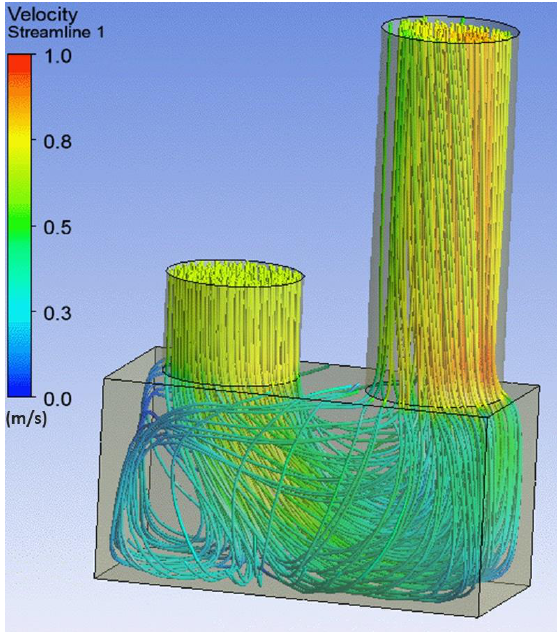
Figure 7. Case 3 box design velocity tracks.